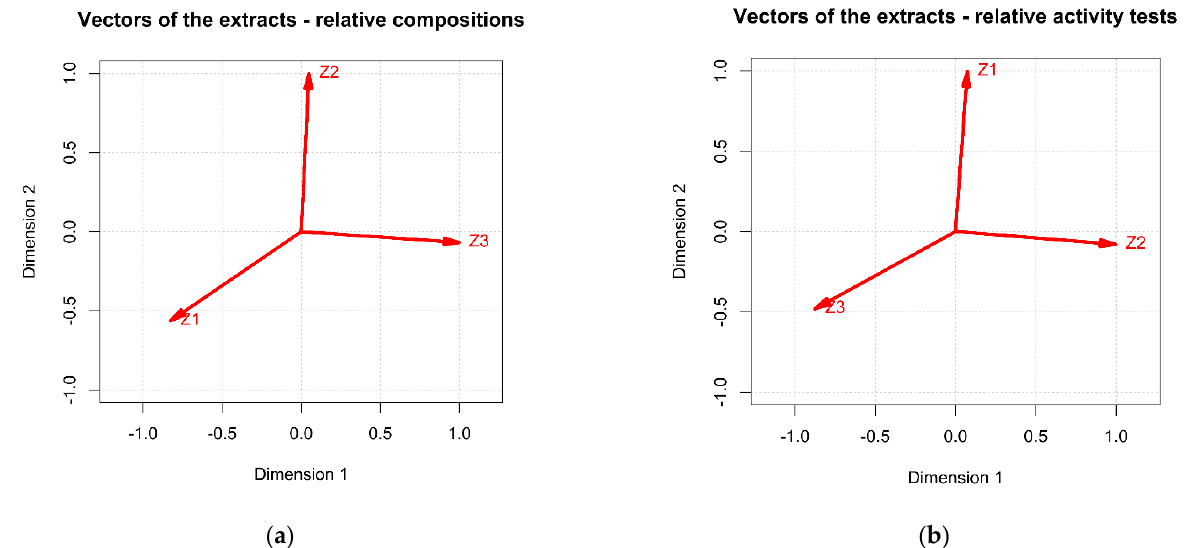
Figure 8. Relations of the Z1 – Z3 vectors in the space of the first two principal components (subjected to VARIMAX rota- tion), regarding their relative compositions ( A ) and relative biological activities ( B